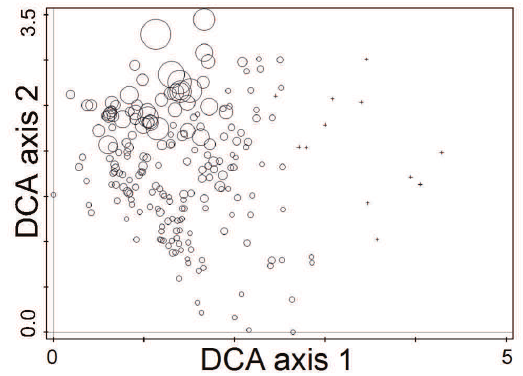
Figure 2. The relative differences in lichen biomass according to the plot positions along DCA axes 1 and 2 (cf. Figure